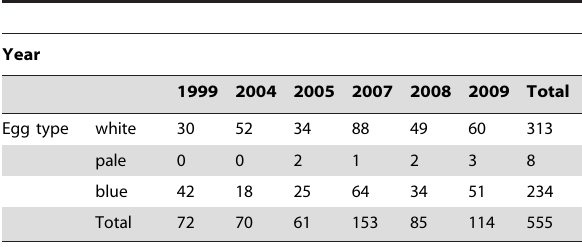
Table 2. Temporal variation in distribution of egg types in ashy-throated parrotbills.